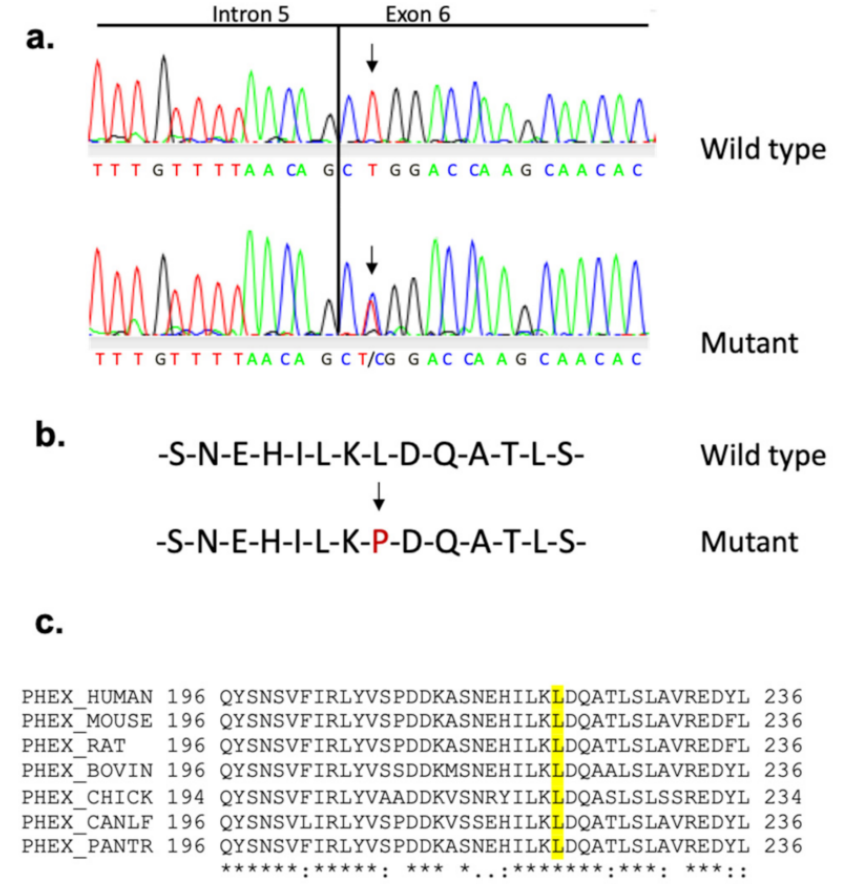
Figure 4. Sequence analysis spanning Phex L222P mutation site. ( a ) Sequence chromatogram of the Phex gene at the level of the splicing site intron 5/exon 6 showing the T > C transition (arrows) with the corresponding amino acid sequence in female mouse. ( b ) The resulting PHEX amino acid sequence with the change colored in red. ( c ) Partial protein alignment of PHEX from different species around the mutation position (amino acid 222 in mouse). The leucine residue at position 222, colored in yellow, is highly conserved between the